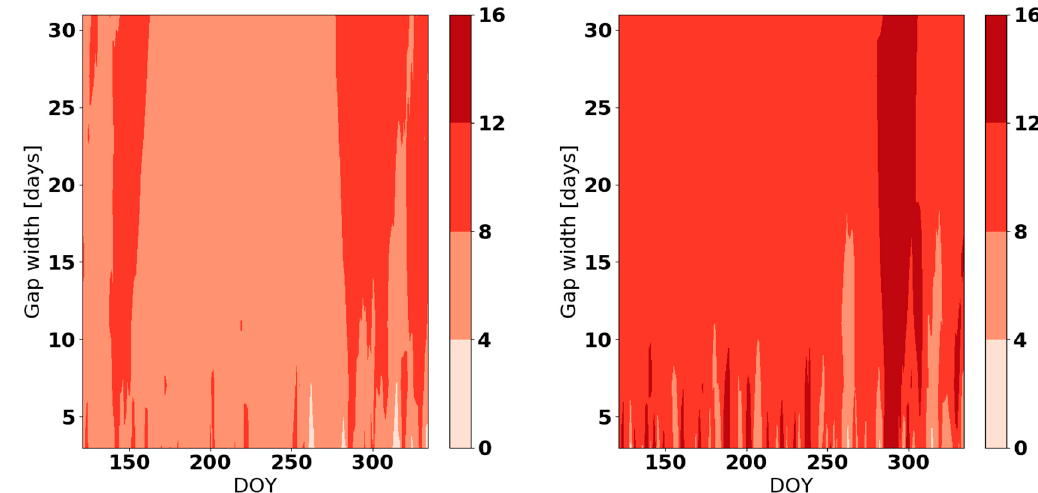
Figure A2. B DEB ( top , left panel ), B ERA5 ( top , right panel ), U(B) DEB ( bottom , left panel ), and U(B) ERA5 ( bottom , right panel ) calculated using data for DOY 121–334 2017 in Gumpenstein.